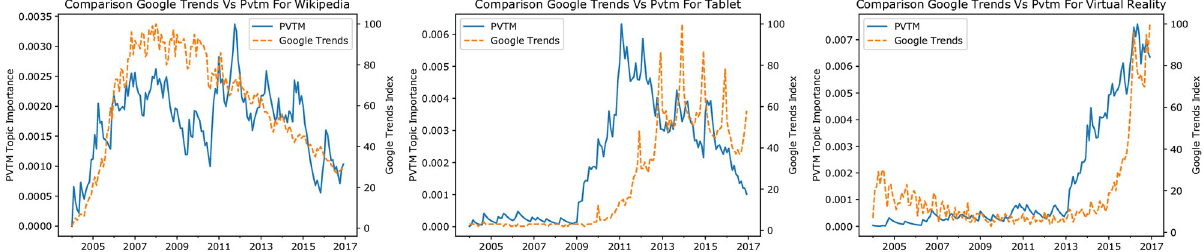
Fig 6. Paragraph vector topic model diffusion indicators obtained from topic modeling compared to Google Trends indices. A: WIKIPEDIA topic. B: TABLET topic. C: VIRTUAL REALITY topic. The PVTM measures are smoothed using the 12-month exponentially weighted moving average of the topic importance over time. We found statistical evidence that the unsmoothed PVTM topic importance measures Granger cause GTI for each of the presented